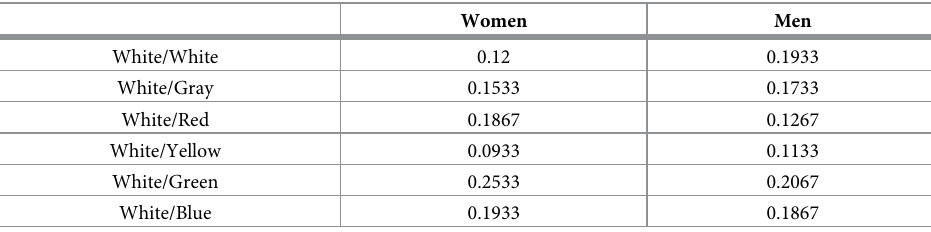
Table 7. Gender FAHP middle layer weight